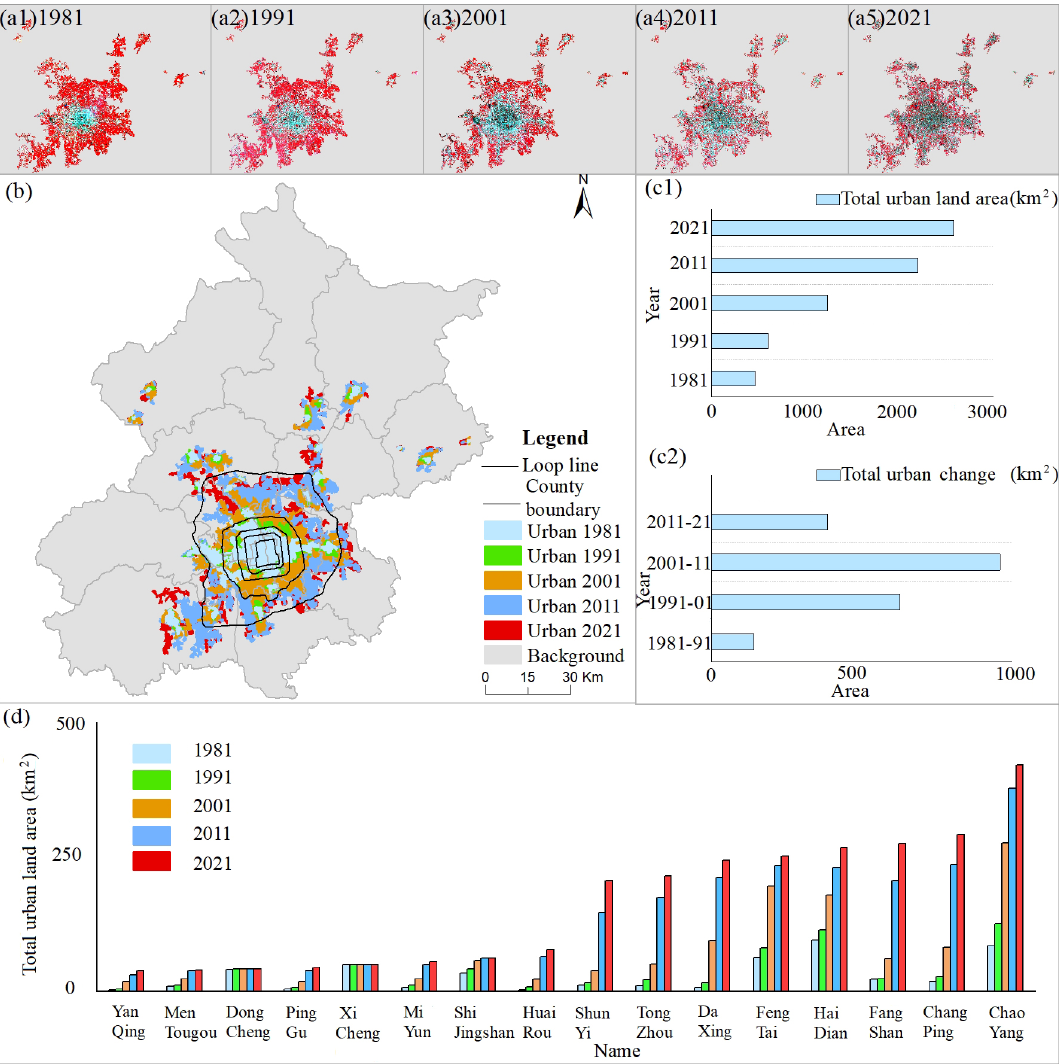
Figure 3. Spatial evolution of urban land in the whole study area and its regional differences from 1981 to 2021. ( a ) False color synthetic Landsat images in the years of ( a1 ) 1981, ( a2 ) 1991, ( a3 ) 2001, ( a4 ) 2011, and ( a5 ) 2021, with the R, G, B bands of 6, 5, 4 from MSS, the bands of 4, 3, 2 from TM5, and the bands of 5, 4, 3 from OLI8; ( b ) Spatial evolution pattern of urban land expansion from 1981 to 2021 in the whole study area; ( c1 ) Statistics of total urban land area in the years of 1981, 1991, 2001, 2011, and 2021, respectively; ( c2 ) Statistics of urban land area change in the periods of 1981–1991, 1991–2001, 2001–2011, and 2011–2021, respectively. ( d ) Total urban land and its change at the district level from 1981 to 2021, including the regions of Yanqing, Mentougou, Dongcheng, Pinggu, Xicheng, Miyun, Shijingshan, Huairou, Shunyi, Tongzhou, Daxing, Fengtai, Haidian, Fangshan, Changping, and Chaoyang, respectively. Table 4. The statistics of urban land occupation rate at the district level in different time stages from 1981 to 2021 in the study area (Area unit: km 2 , Rate unit: %).